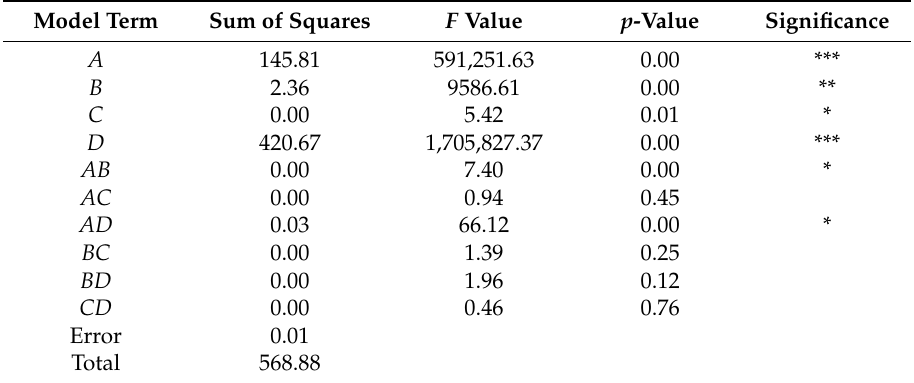
Table 4. Results of ANOVA for the pre-flood period runoff simulation.